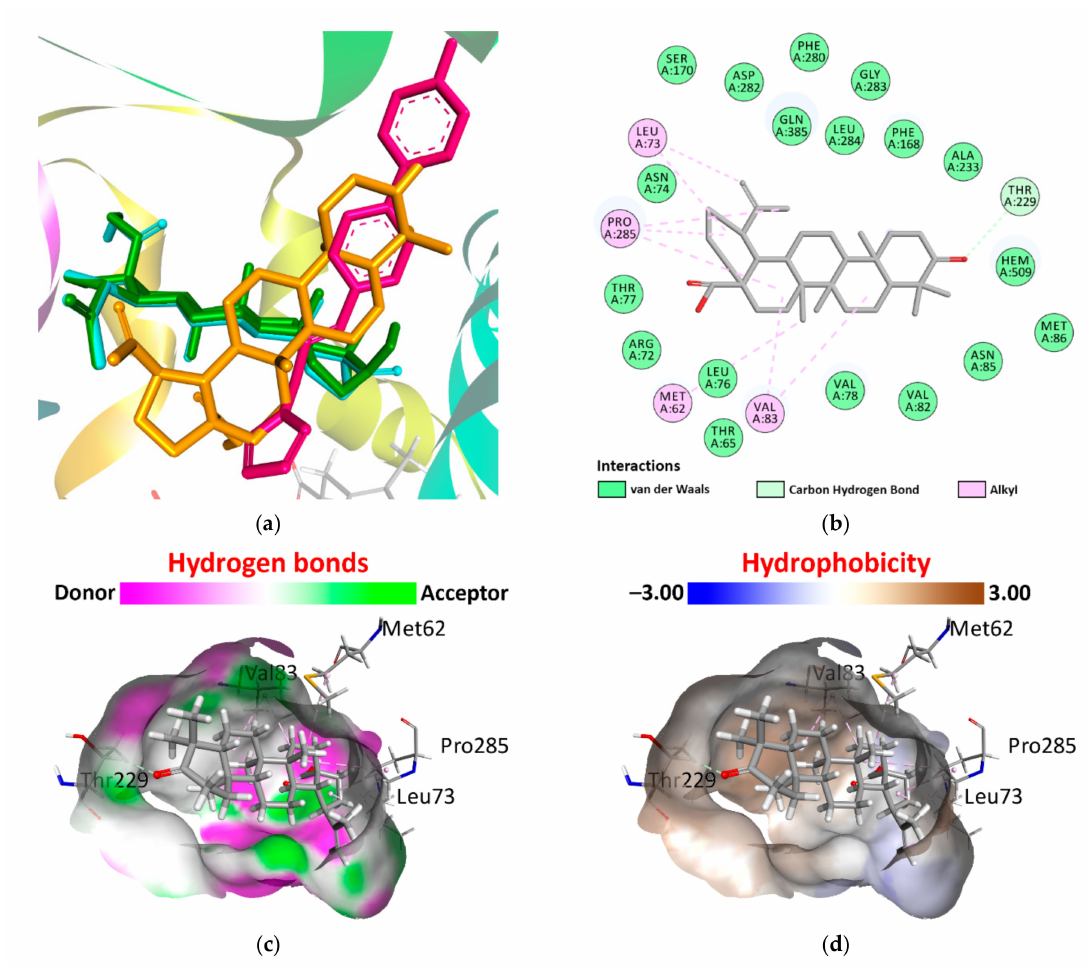
Figure 2. ( a ) Docking poses for N5Z (pink), betulin (green), betulonic (cyan), and betulinic (orange) acids in active site of Mtb CYP121 protein; ( b ) 2D plot of interactions between Mtb CYP121 and betulonic acid; ( c ) hydrogen bonds and ( d ) hydrophobicity surfaces of Mtb CYP121 active